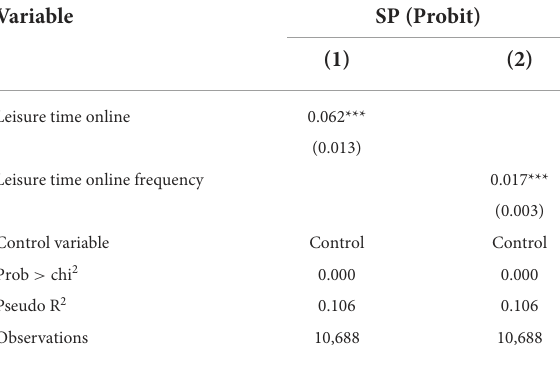
TABLE 4 Robustness test: The impact of leisure time online on sport participation